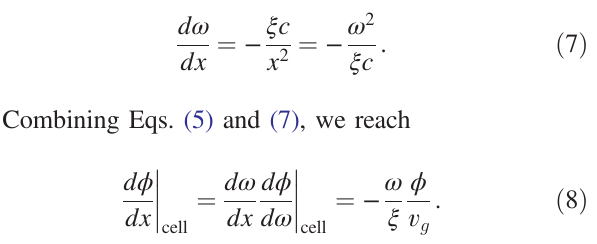
FIG. 6. Accumulated phase advance error given by manufac- turing tolerances for a 30-cm structure and 2-mm iris aperture radius at different